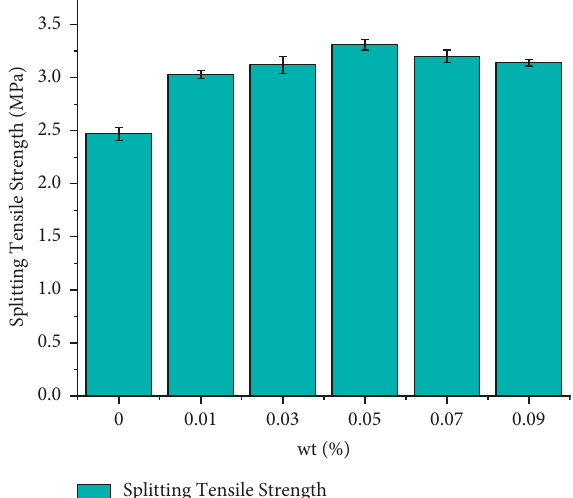
Figure 4: Splitting tensile strength test of ZRJ-S1 reinforced ce- ment-based materials.